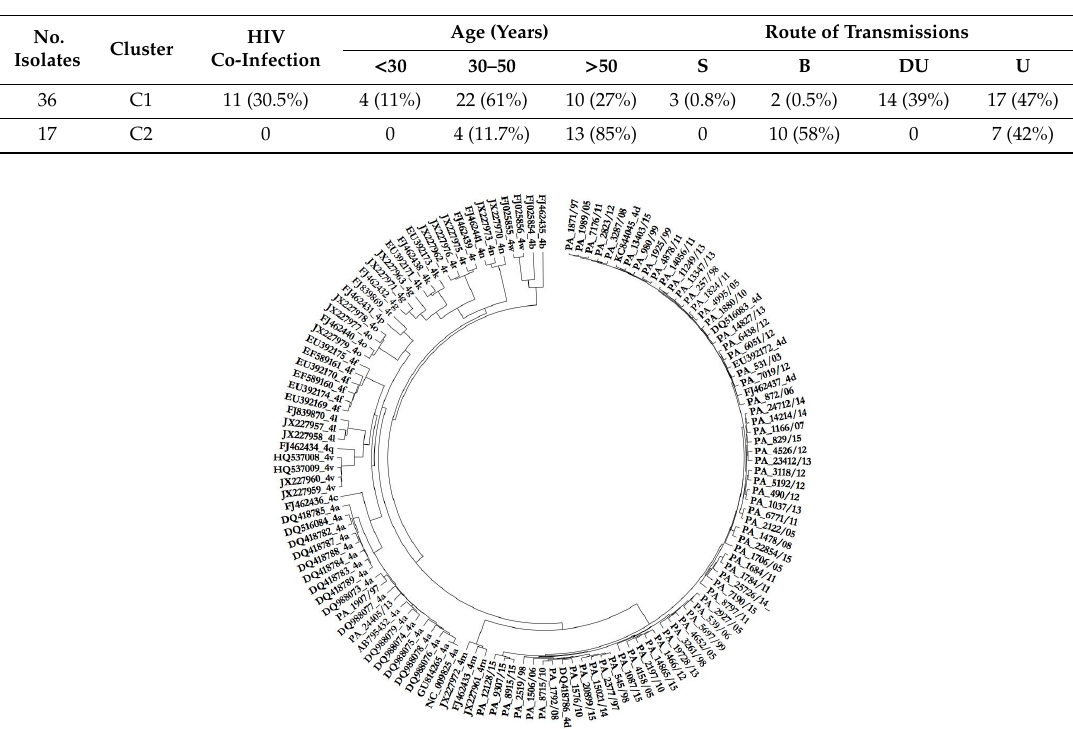
Table 1. Demographic and clinical features of HCV-4d infected patients studied. S: Sexual relations, B: Blood, DU: Drug use, U: Unknown.